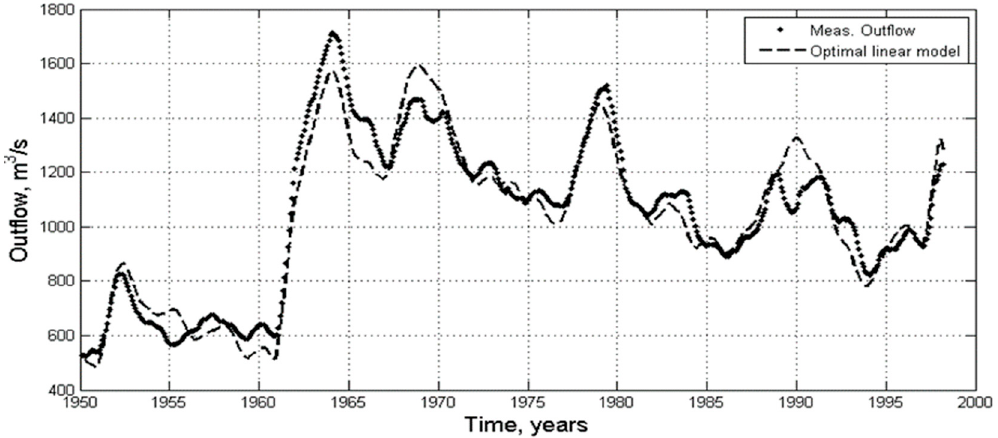
Figure 13. Simulations comparing fitted linear outflow model to measured outflow.